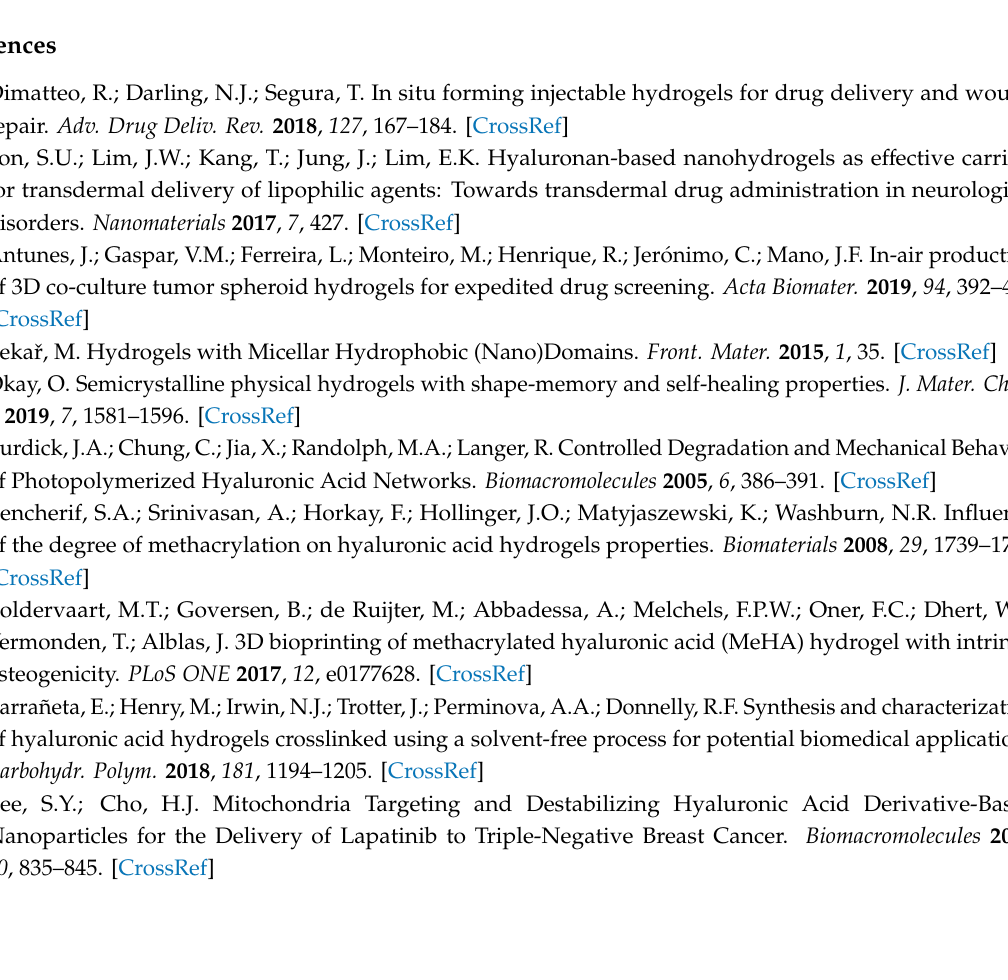
Figure S1: The formation of the mixed anhydride in isopropanol-d8 occurs at 5 ◦ C; Figure S2: reaction of undecylenic acid at (A) room temperature and (B) 5 ◦ C performed in THF d8; Figure S3: Example of integral of HA-UDA; Figure S4: Determination of degree of substitution by hydrolysis of HA-UDA (DS GC = 35%, 240,000 g / mol) using NaOD; Figure S5: Estimation of degree of substitution determined by NMR in D 2 O and sodium hydroxide compared with GC; Figure S6: Infrared spectra of HA-UDA (6,000 g / mol, DS = 46%); Figure S7: Infrared spectra of native HA used for the chemical modification; Figure S8: Encapsulation of Dio / DiI and Nile red in HA-UDA (110,000 g / mol DS = 20%) and cross-linking mediated by Irgacure 2959; Figure S9: Size distribution by intensity for HA-UDA loaded by α -Tocopherol; Figure S10: Size (Z-average and standard deviation) for HA-UDA; Table S1: SEC-MALLS analyses of the HA-samples used for the optimization study; values of weight average molar mass (Mw) and polydispersity index (Mw / Mn) and intrinsic viscosity are reported; Table S2: Gelation time as a function of APS / TEMED or APS / Riboflavin, degree of substitution and concentration of derivative; Table S3: Gelation time as a function of initiator, degree of substitution and concentration of derivative for